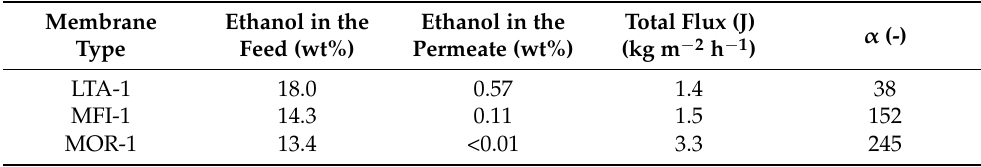
Table 3. Dehydration performance measured by pervaporation tests with a distillate solution as feed supplied at 75 ◦